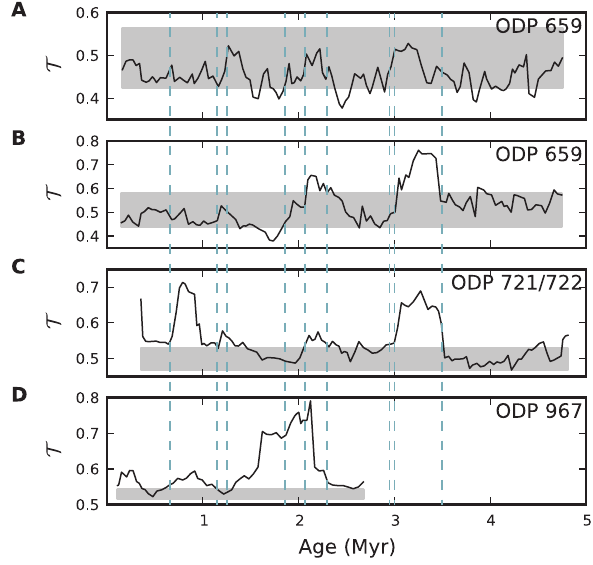
Fig. 9. Evolution of RN transitivity T for (A) the δ 18 O record from ODP site 659, and the dust flux records from ODP sites (B) 659, (C) 721, and (D) 967. T reveals changes in the regularity of African climate during the Plio-Pleistocene for the latter three records. Here we used a detrending window size W ∗ D = 500 kyr, recurrence window size W ∗ = 410 kyr and step size ∆ W ∗ = 41 kyr, embedding dimension m = 3 and de- lay τ ∗ = 10 kyr. The recurrence threshold ε was chosen adaptively to yield a fixed edge density ρ = 0 . 05 . The grey bars represent the 5% and 95% quantiles with respect to the test distribution obtained from 10 , 000 realisations of our null-model for each record sepa- rately. Vertical dashed lines indicate the detected epochs of transi- tions discussed in the main text.